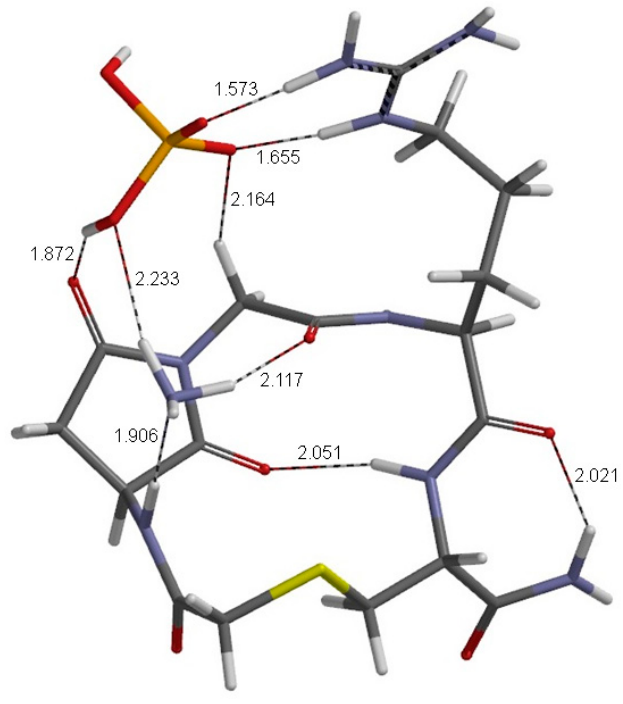
Figure 9. The geometry of PC (product complex) directly connected to TS2 (Figure 8). Selected interatomic distances are shown in Å. Grey: carbon; white: hydrogen; blue: nitrogen; red: oxygen; orange: phosphorus; yellow: sulfur.